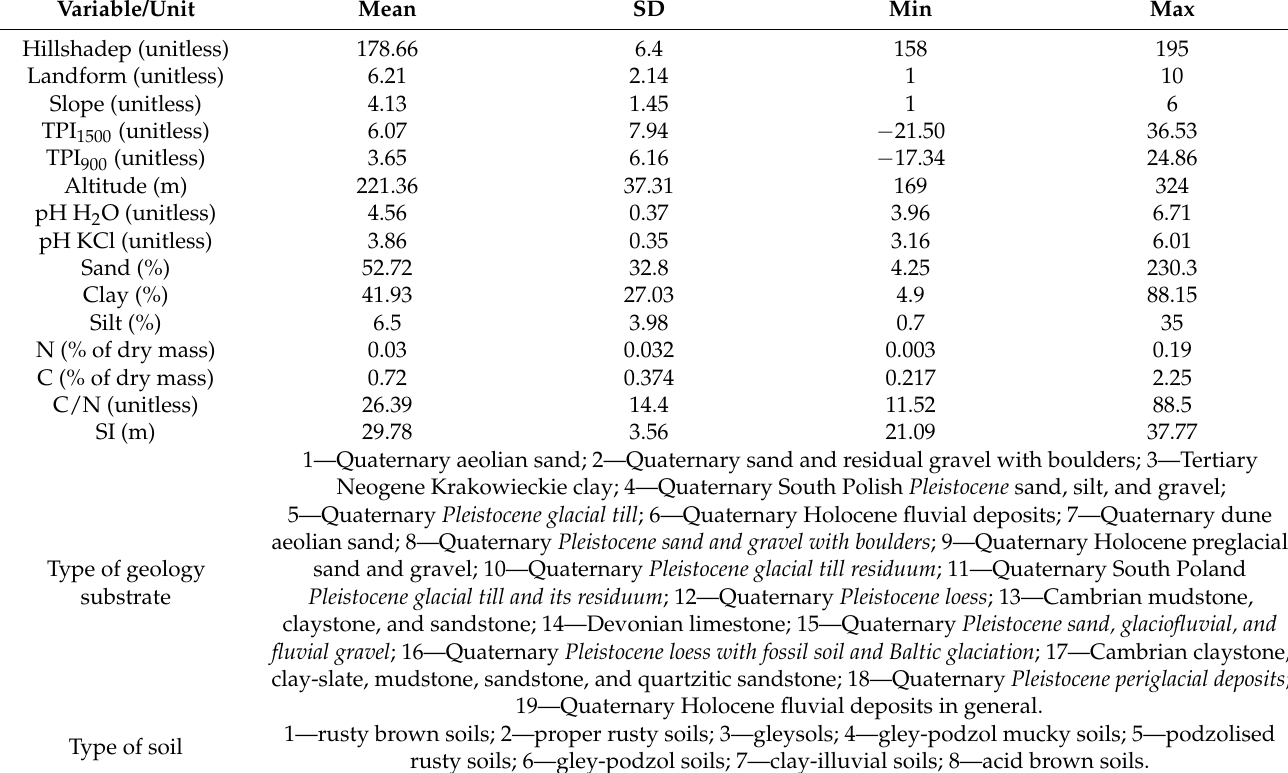
Table 2. Characteristics of the soil and physiographic variables estimated for sample